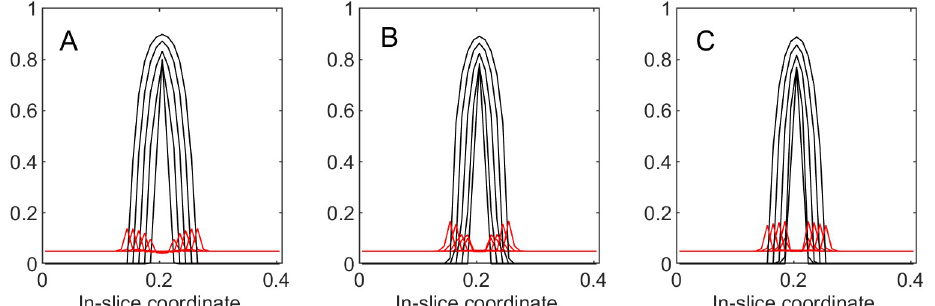
Fig 15. Tumor and ECM dynamics for various ECM growth coefficients. “Slices” at times 100, 200, ... , 500. A: ^ b ¼ 20 . B: ^ b ¼ 100 . C: ^ b ¼ 500 . Note that higher b 3 values increase “active” ECM response, slowing down tumor 3 3 3 growth.